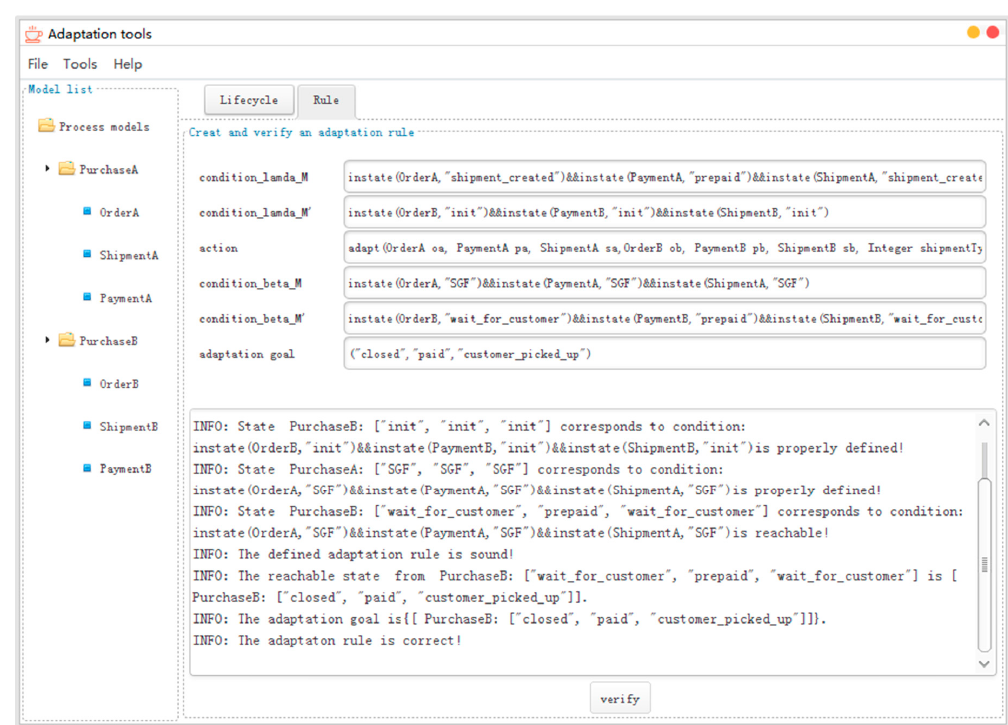
Figure 6. The screenshot of the verification results of Example 4 through the tool.